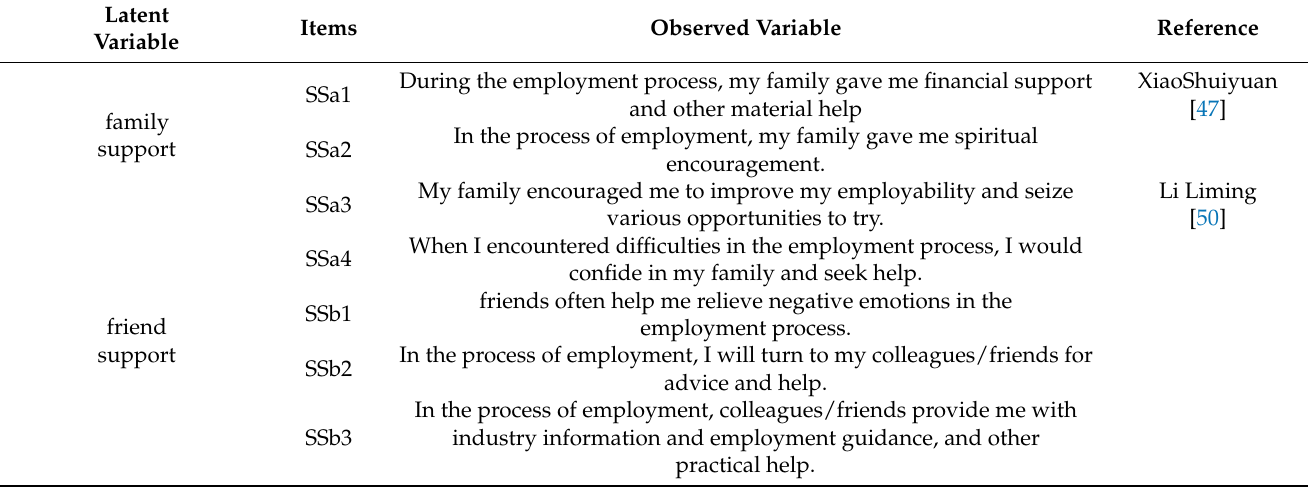
Table 1. Variable measurement